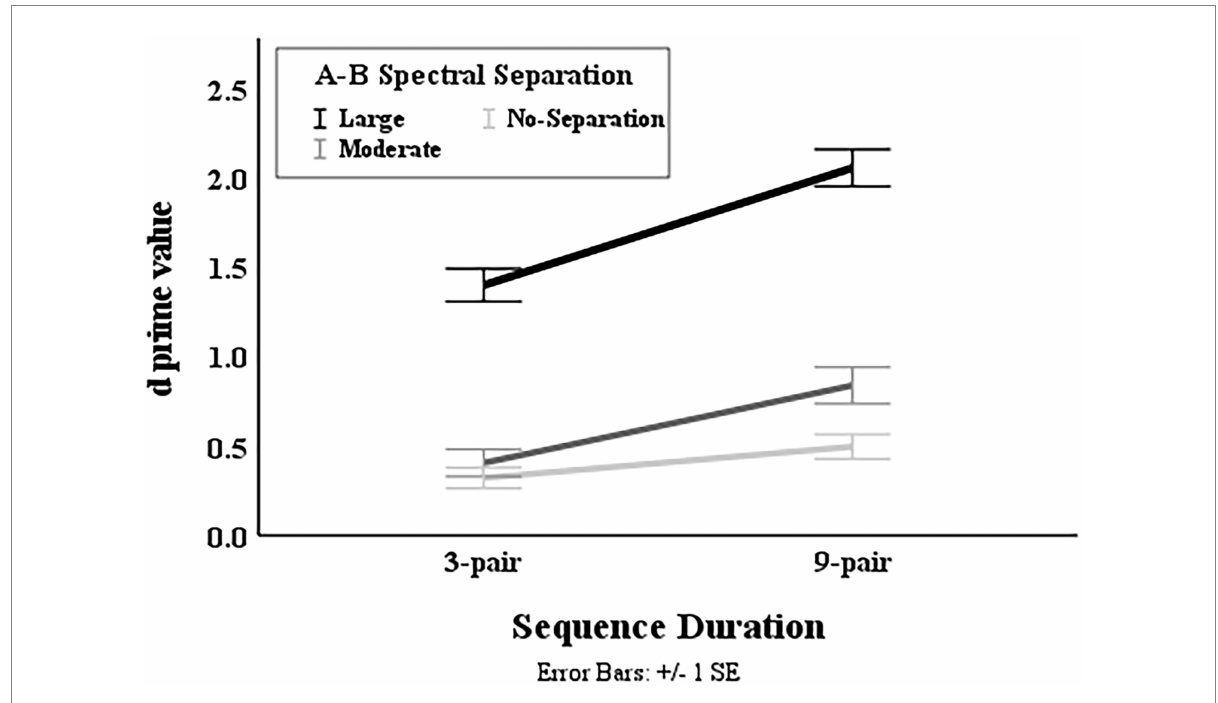
FIGURE 6 Illustration of mean d ¢ value in the two sequence durations at different A–B spectral